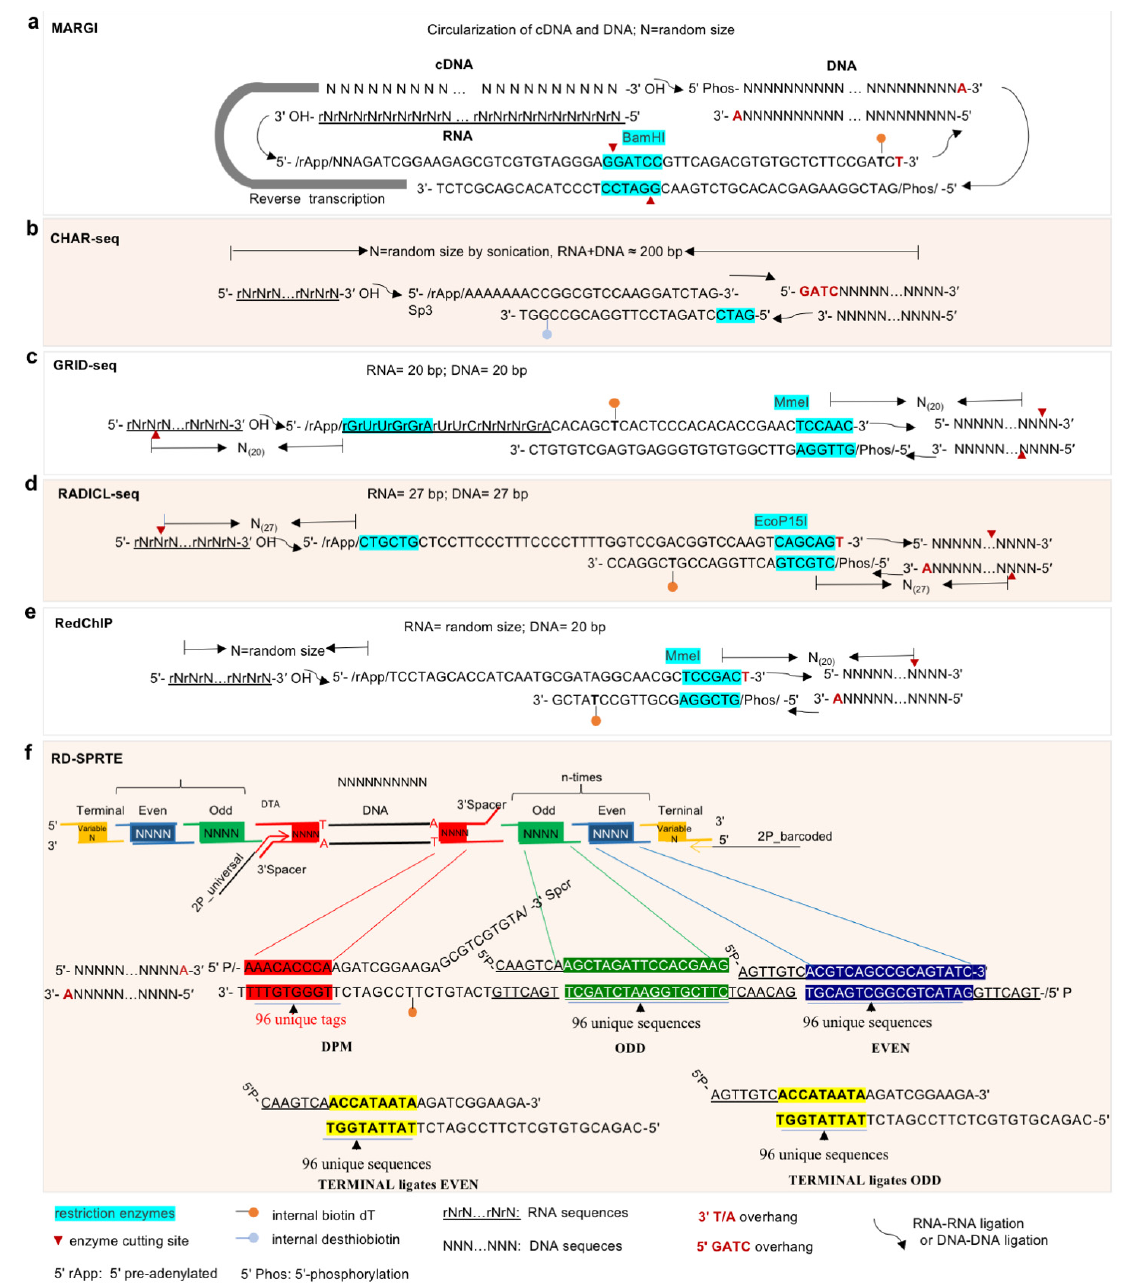
Figure 3. Schematic diagram showing the strategies for the design and modi fi cation of linker sequences in ligation-based approaches for identifying RNA–DNA interactions. ( a ) MARGI use double-stranded (ds) DNA linker with 10-nt 5 ′ overhang and 3 ′ A overhang at the top strand. The 5 ′ end of linker is adenylated (5 ′ rApp) for the ligation with the 3’ OH RNA. The 3 ′ end of dsDNA linker is phosphorylated (Phos) for proximity ligation with genomic DNA. Le tt ers in blue: restriction enzyme site. N: random base of DNA. rN : random base of RNA. The lolypop icon indicates the internal biotin modi fi cation for further puri fi cation of products, the red triangle icon indicates the cu tt ing site of restriction enzyme. ( b ) ChAR-seq use dsDNA linker with 6-nt 5 ′ overhang at the top strand and 4-nt 5 ′ overhang at the bo tt om strand. The 5 ′ end of linker is adenylated (5 ʹ rApp) for the ligation with the 3’ OH RNA. The 3 ′ end of linker ligased to genomic DNA via sticky ends after DpnII digestion. ( c ) GRID-seq use a biotin-labeled bivalent linker consisting of a 14-nt single-stranded RNA (ssRNA) portion for ligation to RNA and a double-stranded DNA (dsDNA) portion for ligation to